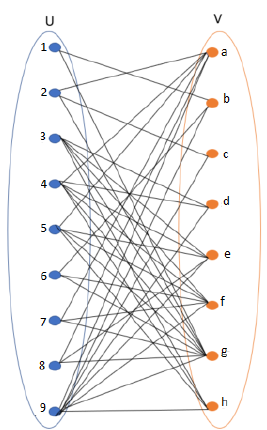
Figure 1. The bipartite graph associated with the formal context depicted in Table